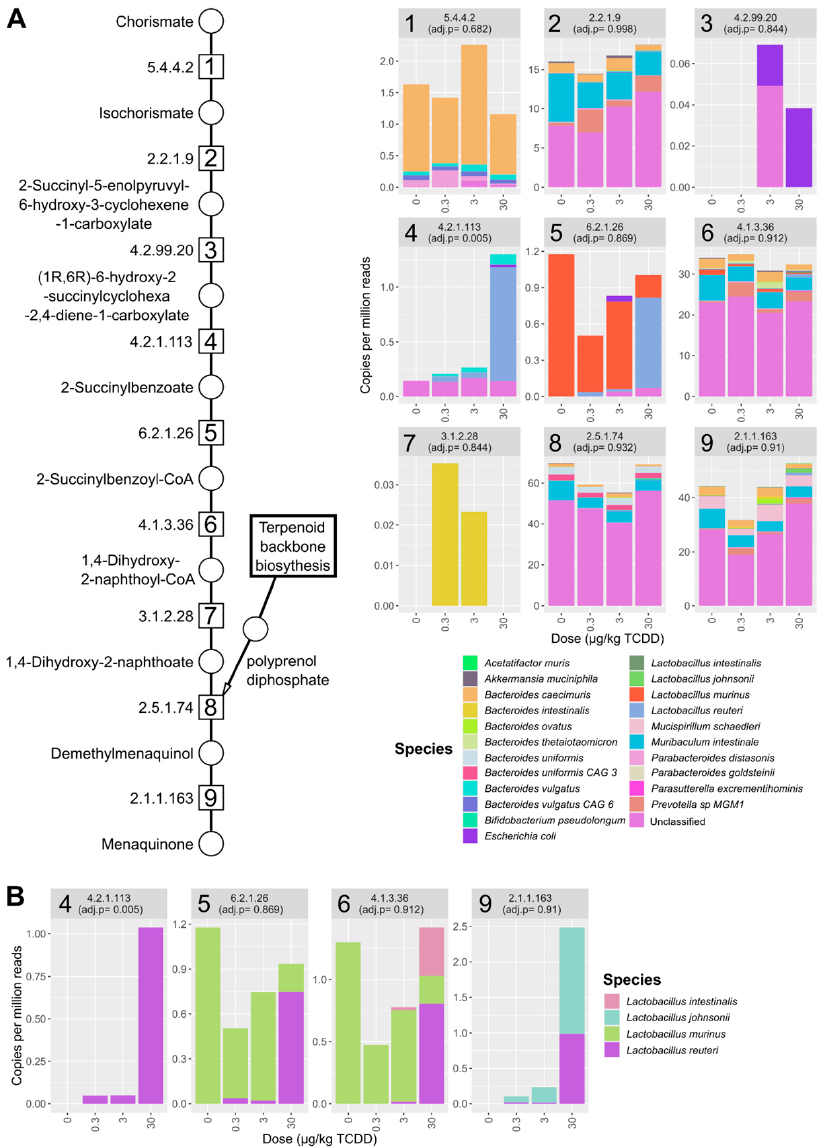
Figure 7. TCDD-elicited effects on menaquinone biosynthesis. ( A ) Relative abundance of menaquinone biosynthesis EC annotations identified in the metagenomic dataset. Individual stacked bar plots are labeled with the EC number matching the enzymatic step in pathway schematic. Stacked bar plots of annotated EC numbers involved in menaquinone biosynthesis. Values are mean relative abundance ( n = 3) classified to the respective species and in cecum samples from male C57BL/6 mice following oral gavage with sesame oil vehicle or 0.3, 3, or 30 µg/kg TCDD every 4 days for 28 days. ( B ) Menaquinone biosynthesis EC numbers classified to Lactobacillus species in the cecum metage- nomic datasets. Adjusted p -values (adj. p ) were determined by Maaslin2 R